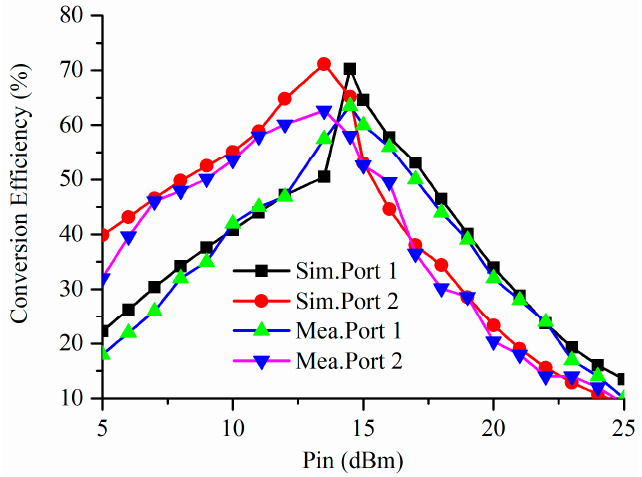
Figure 17. Simulated and measured conversion efficiency at 5.85 GHz.